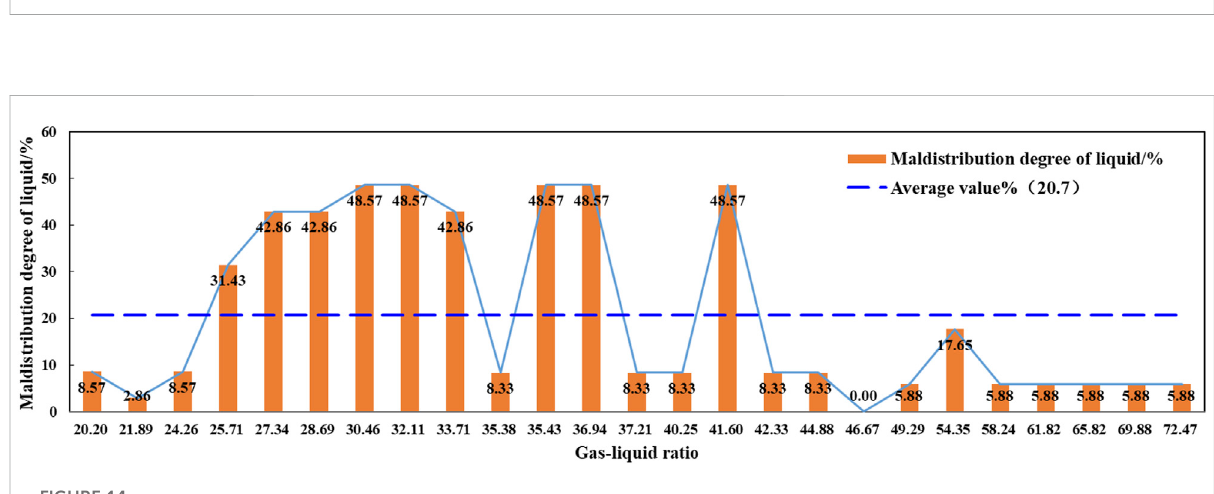
FIGURE 13 Histogram of gas – liquid ratio and maldistribution degree of gas in annular fl ow in horizontal manifold without fl ute pipes (liquid injection volume 0.16L/s+0.35L/s).